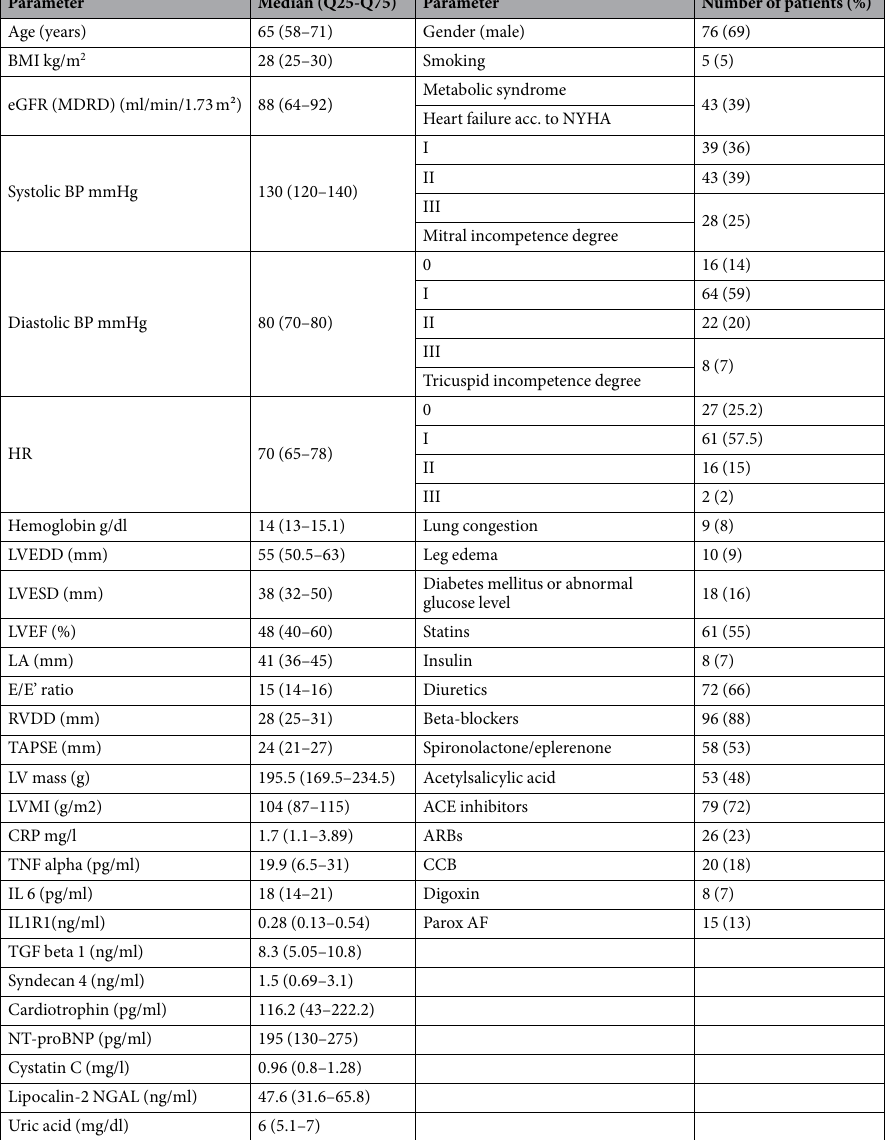
Table 1. Characteristics of patients, standard echocardiographic parameters and biochemical biomarkers in HF patients – quantitative and categorical variables. ABBREVIATIONS: BMI, body mass index; eGFR (MDRD), glomerular filtration rate on the basis of the study Modification of Diet in Renal Disease; BP, blood pressure; HR, heart rate; LVEDD, left ventricular end-diastolic diameter; LVESD, left ventricular end-systolic diameter; LVEF, left ventricular ejection fraction; LA, left atrial diameter; E/E’, ratio of early mitral diastolic inflow velocity to early diastolic mitral annular velocity; RVDD, right ventricular diastolic diameter; TAPSE, tricuspid annular plane systolic excursion; LVMI, left ventricular mass index; NYHA, New York Heart Association classification of heart failure; ACE inhibitors, angiotensin-converting enzyme inhibitors; ARBs, angiotensin receptor blockers; CCB, calcium channel blocker; TGF beta 1, transforming growth factor beta 1; NT-proBNP, N-terminal pro-brain natriuretic peptide; NGAL, neutrophil gelatinase-associated lipocalin; TNF alpha, tumor necrosis factor alpha; IL1R1, interleukin 1 receptor, type I; Parox AF, paroxysmal atrial